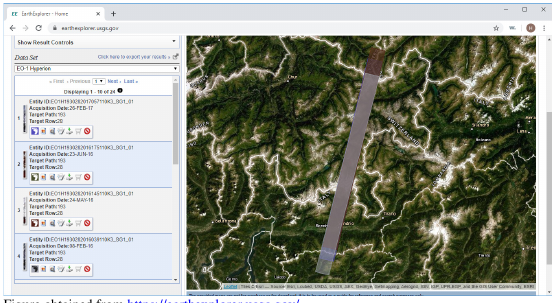
Figure obtained from https://earthexplorer.usgs.gov/ Figure 1. Screenshot of USGS’s Earth Explorer